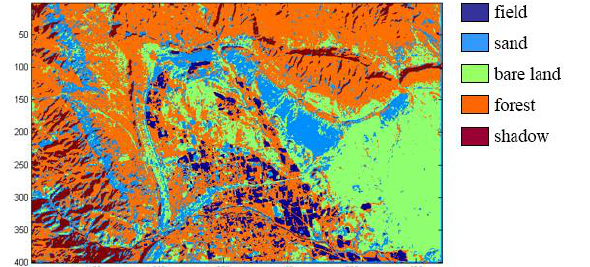
Figure 6. the classification results of the selected remote sensing image